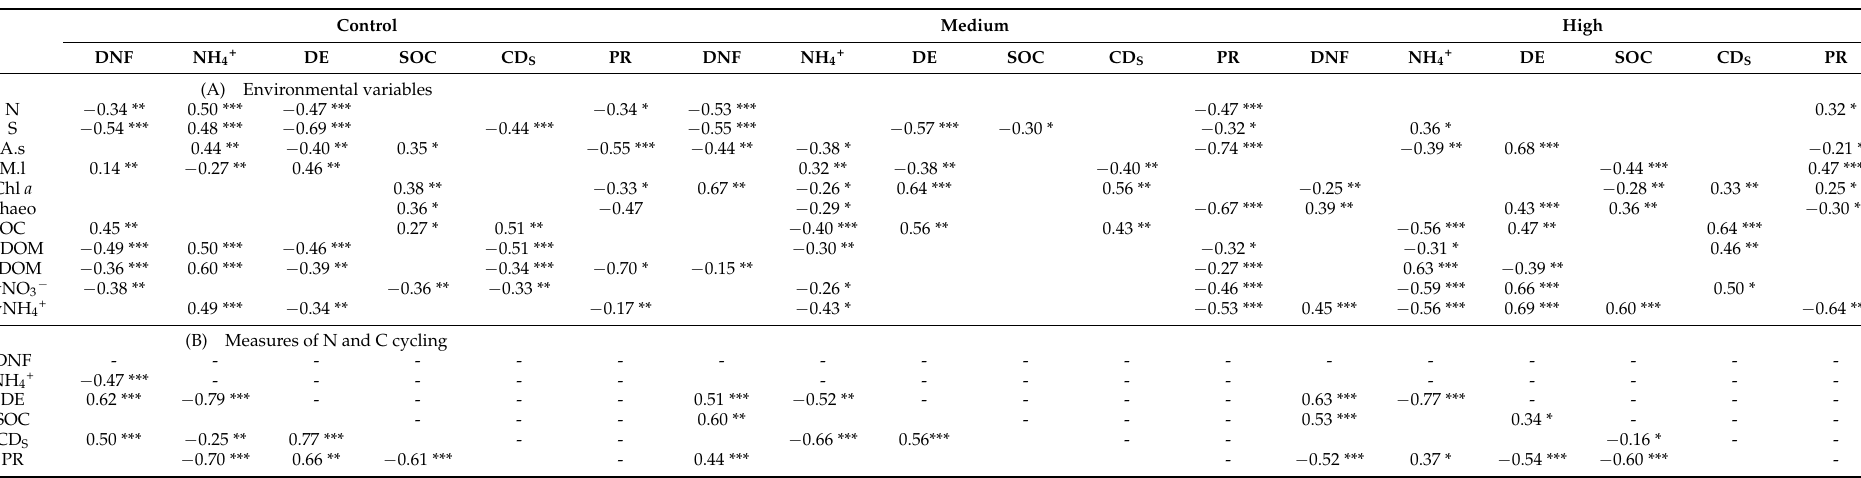
Table 3. Pearson correlation coefficients between (A) measures of N and C cycling and environmental variables and (B) N and C cycling during the summer as a function of nutrient enrichment treatment (n = 18). Data shown are significant relationships ( p < 0.05), see Figure S2 for all